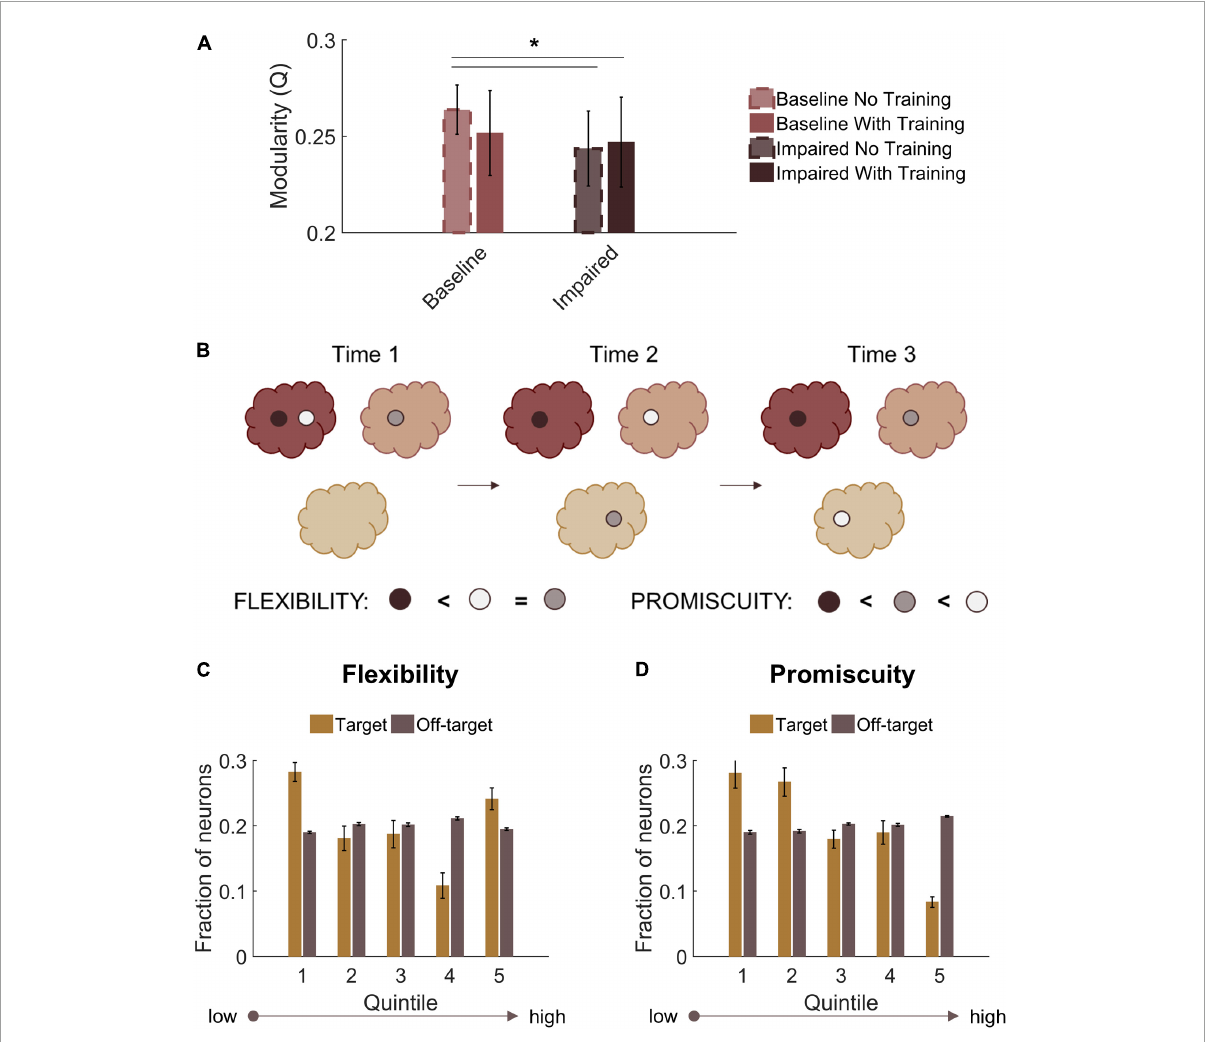
FIGURE8 Target output neurons have low promiscuity among network communities. (A) Both trained and untrained networks with STDP impairment have lower modularity than untrained baseline networks. (B) Neurons that change their community affiliation frequently have high flexibility. If their affiliation shifts between unique communities, those neurons also have high promiscuity. (C) Target neurons are more likely to fall in the first or fifth quintiles of the flexibility distribution. (D) Target neurons have low promiscuity, most likely falling into the first two quintiles of the distribution. * p <